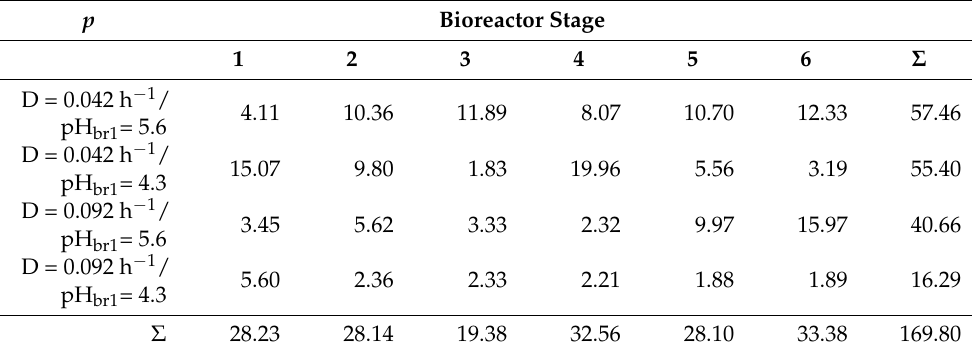
Table 3. Quality of simulation p for individual bioreactor stages and data sets given by the weighted residual square sum over all metabolites (see Figure 2). Data set of D = 0.092 h − 1 /pH br1 = 5.6 was not used for parameter optimization and serves for validation of the estimated parameter